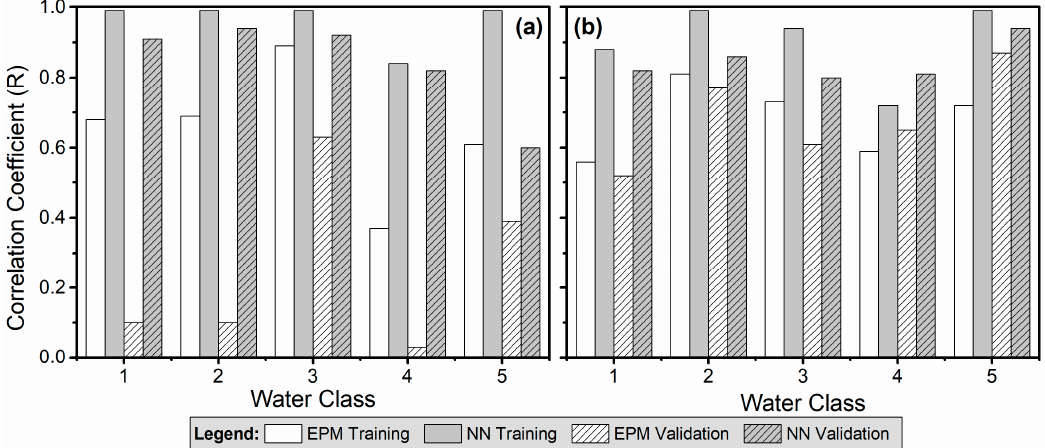
Figure 5. Comparison of correlation coefficients (in absolute terms) for training and validation datasets for class-specific empirical predictive models (EPM) and neural networks (NN) ( a ) for Chl-a models and ( b ) for SS models.